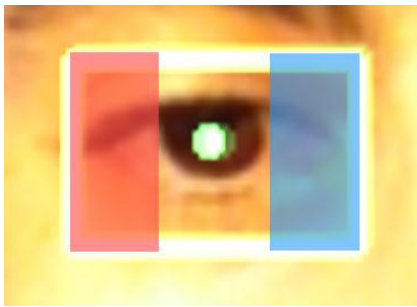
Figure 12. Eye tracking processing